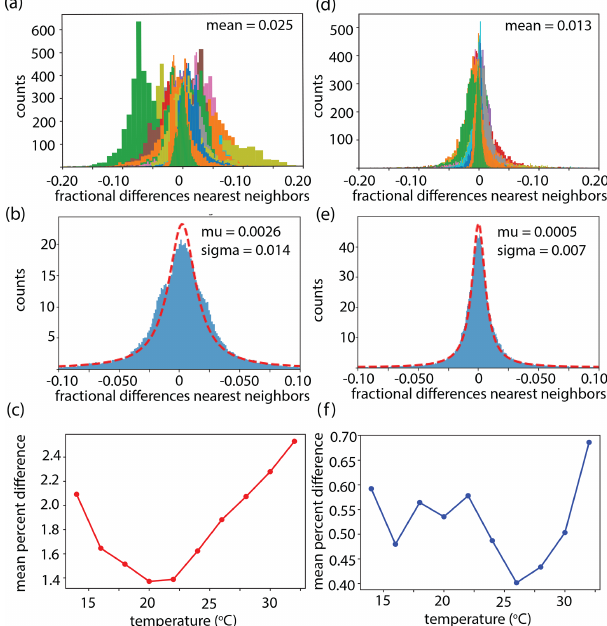
Figure 8. Histogram of the fractional differences between nearest neighbors sites (a) without and (d) with the temperature correction applied. Different colors represent different pairs of neighboring sites. Histogram of the fractional differences between all aggregated nearest neighboring sites (b) without and (e) with the temperature correction applied fit to a Lorentz distribution. Network mean of the percent difference for each nearest neighbor pair averaged by 2 ◦ C bins (c) without and (f) with temperature correction